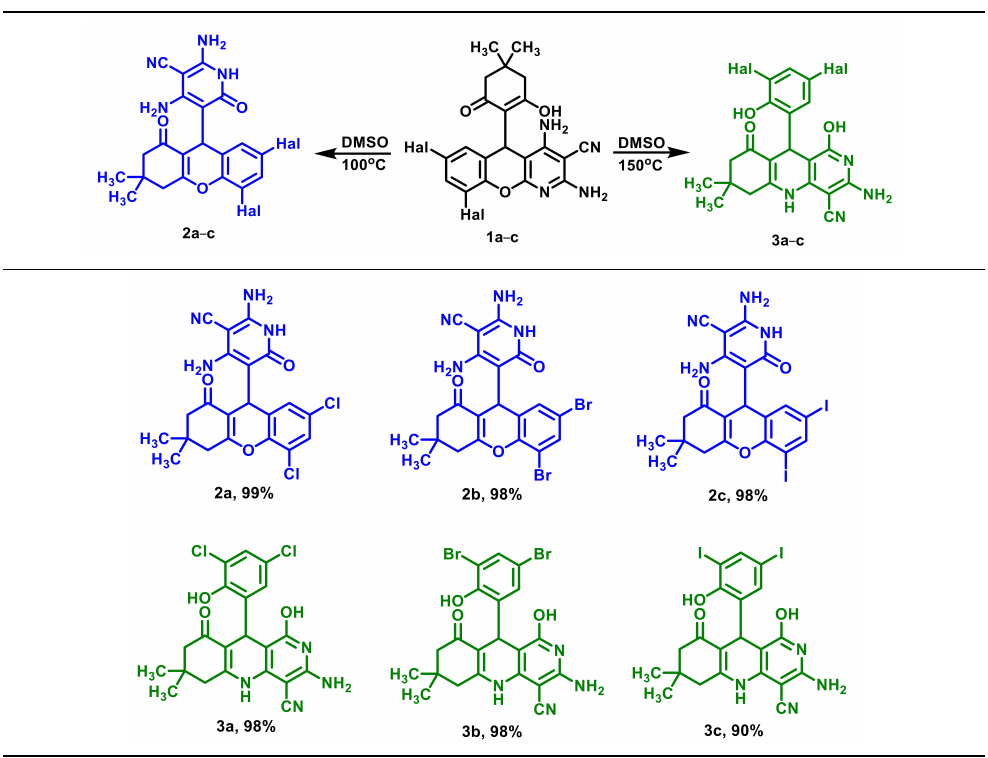
Table 2. Thermal rearrangement of 7,9-dihalogen-substituted 5-(2-hydroxy-6-oxocyclohexyl)-5 H